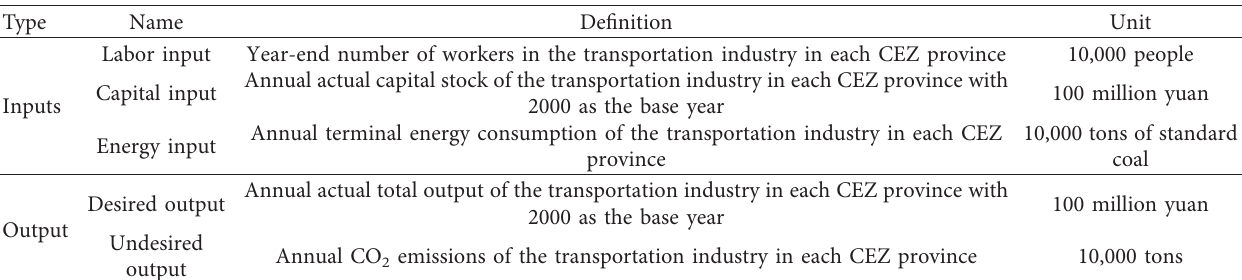
Table 1: TIEE evaluation